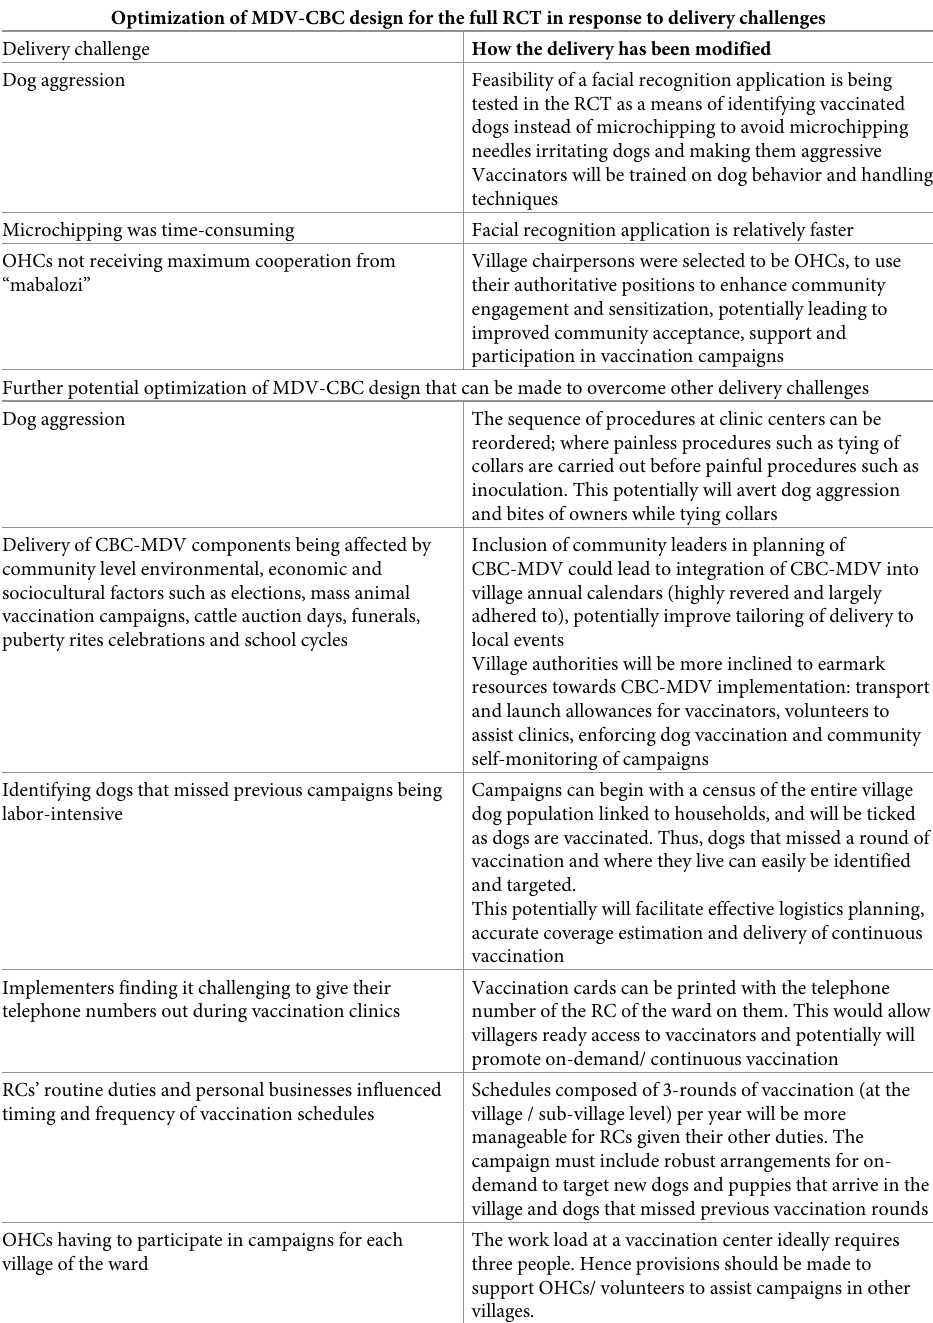
Table 6. How CBC-MDV can be optimized for replication in the full-scale trial and dissemination in other